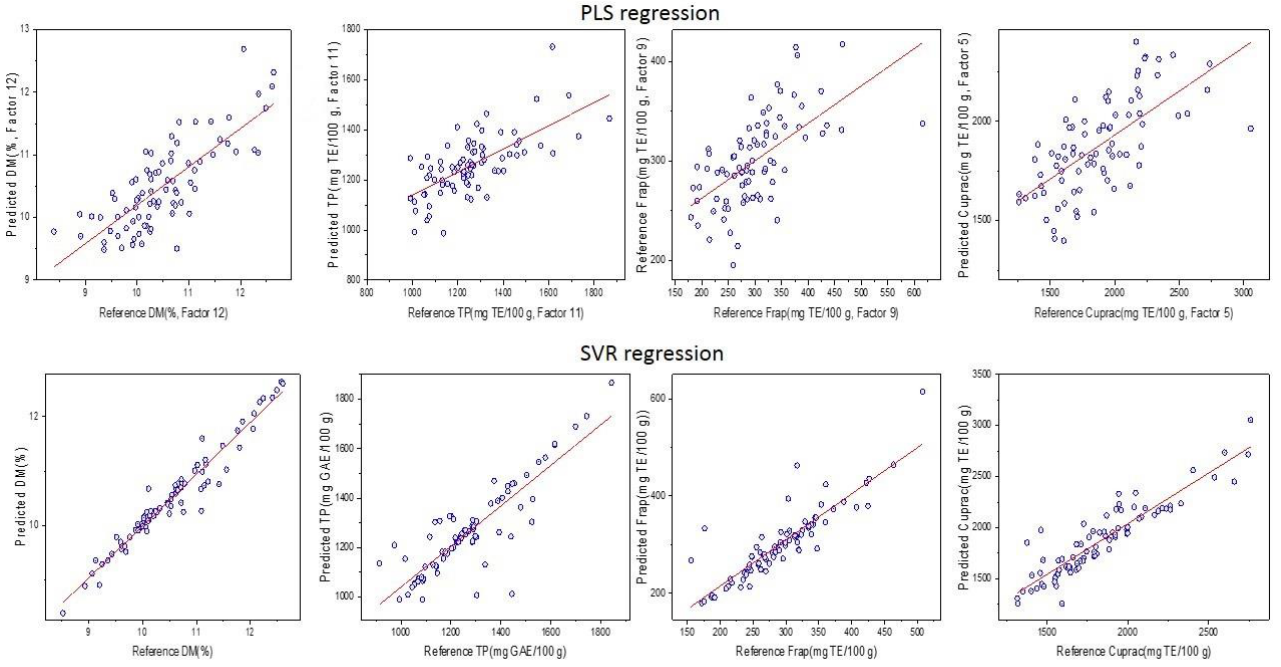
Figure 5. Predicted vs. reference results for the fusion of NIR and MIR spectroscopy datasets for the prediction of dry matter, TPC, FRAP, and CUPRAC contents. Table 5. Statistical parameters were obtained from the application of the PLSR and SVR algorithms on the combined NIR and MIR spectra datasets, using different pre-processing methods.